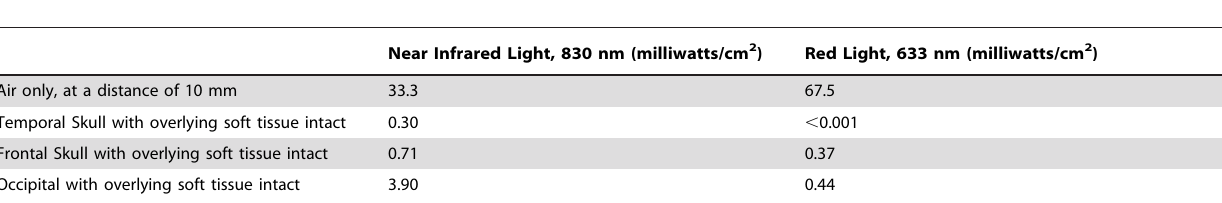
Table 2. Transmission of Near Infrared and Red Light through Sagittally Cut Intact Cadaver Head and Intact Shoulder and Temporomandibular